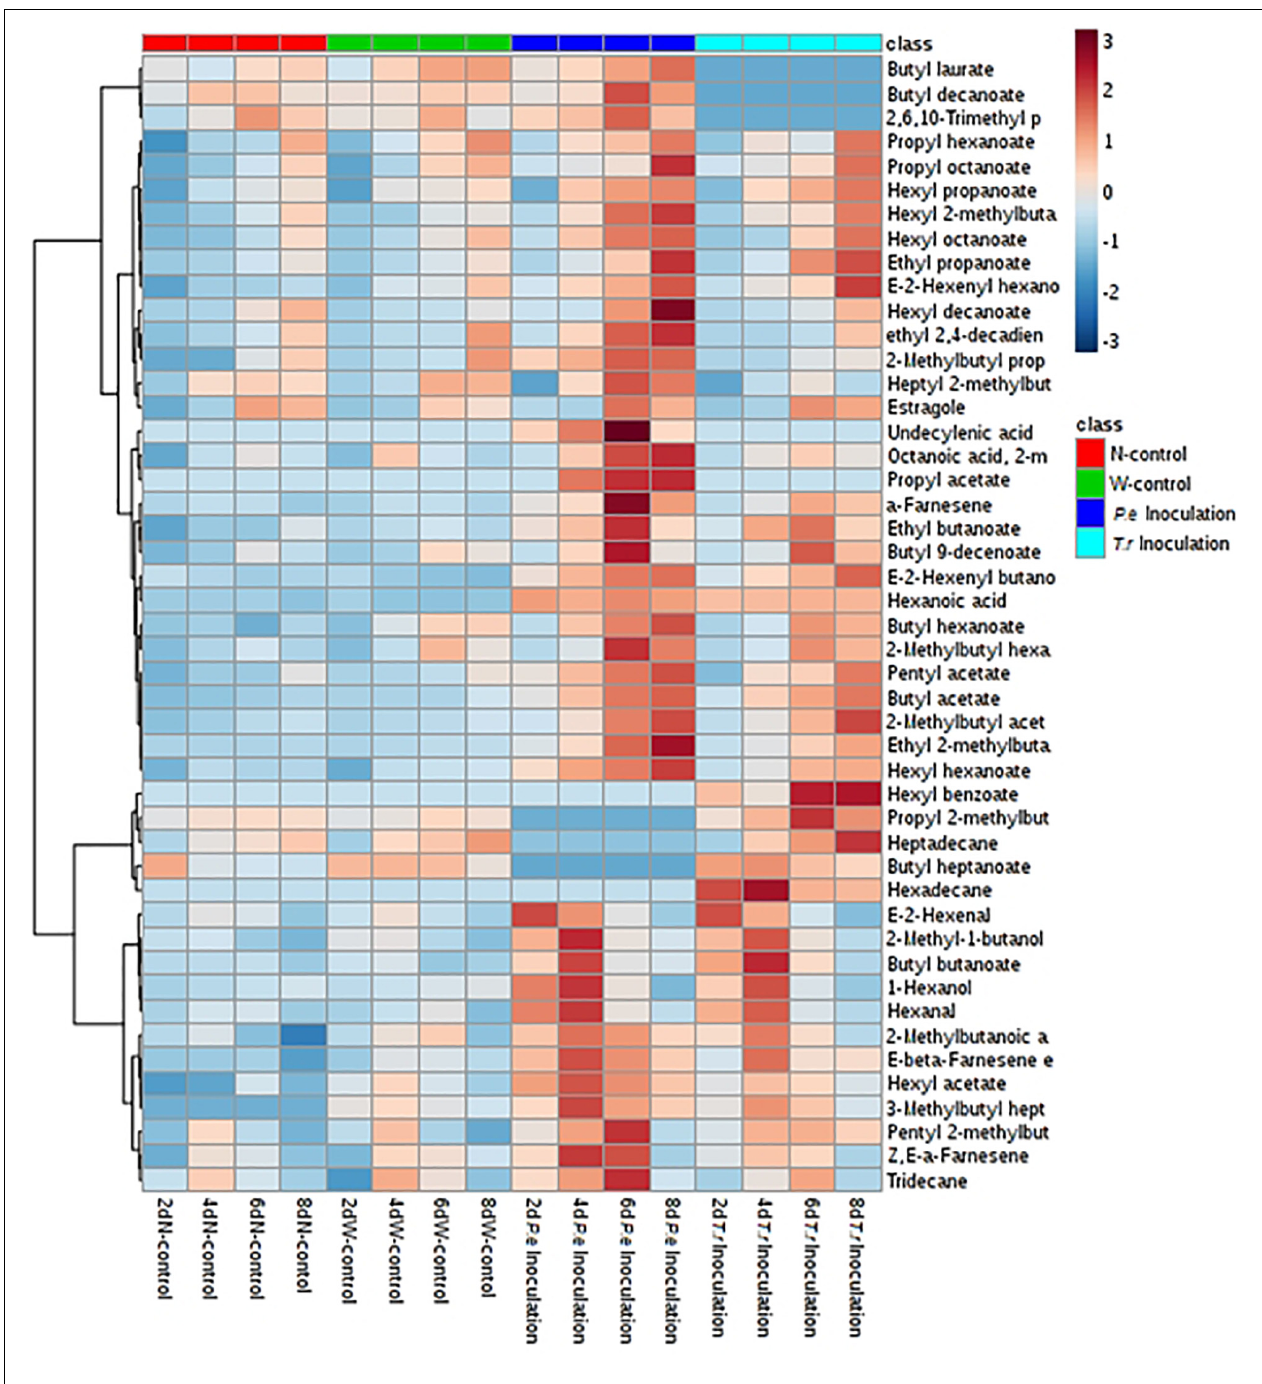
FIGURE 6 | Heatmap cluster based on the normalized quantities of the identified volatiles in apple fruits. Each line in the heatmap represents a volatile compound. The lowest content is in the darkest blue and the highest content is in the darkest